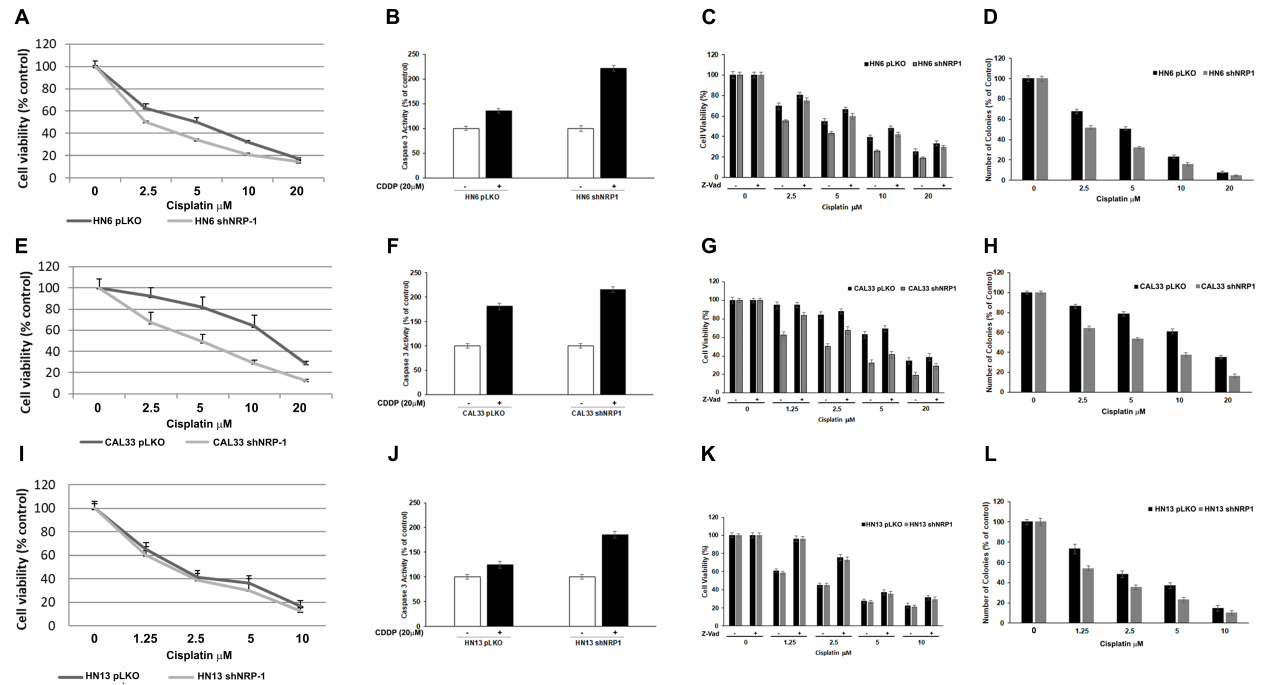
Figure 5. Cell viability of the NRP-1-silenced HNSCC cells compared to the control cells upon cisplatin treatment. Three independent experiments were performed to calculate the mean and standard deviation. ( A , E , I : HN6, CAL33, and HN13, respectively). Caspase 3 activity was assayed in HN6, CAL33, and HN13 cells ( B , F , J , respectively) transfected with the control vector (pLKO) or with ShNRP1 in the presence or not of cisplatin (20 µ M) for 24 h. The plotted values represent the mean ± s.e.m. of three independent experiments. At 72 h, the CDDP (20 µ M) effect on cell viability was modulated by NRP1 silencing and rescued by the addition of Z-VAD-FMK to the culture medium ( C , G , K : HN6, CAL33, and HN13, respectively). Histograms represent the percentage of colonies consisting of at least 30 cells and normalized on untreated cells, which were counted following clonogenic assays performed in pLKO or ShNRP1 HN6, CAL33, and HN13 cell lines that were treated with different doses of CDDP for 10 days ( D , H , L ). Error bars indicate the standard error mean derived from three independent